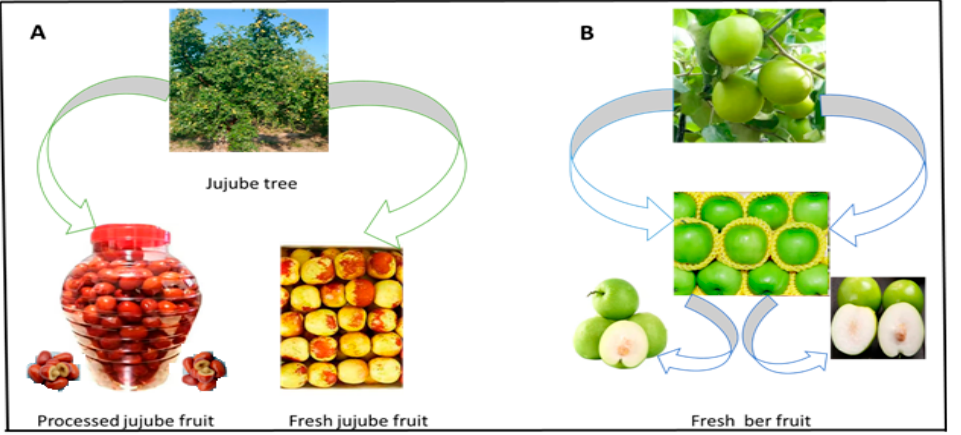
Figure 6. The packing of Ziziphus fruit: ( A ) the processed and fresh fruit of Z. jujuba ; ( B ) the fresh fruit of the green cultivar Z. mauritiana .